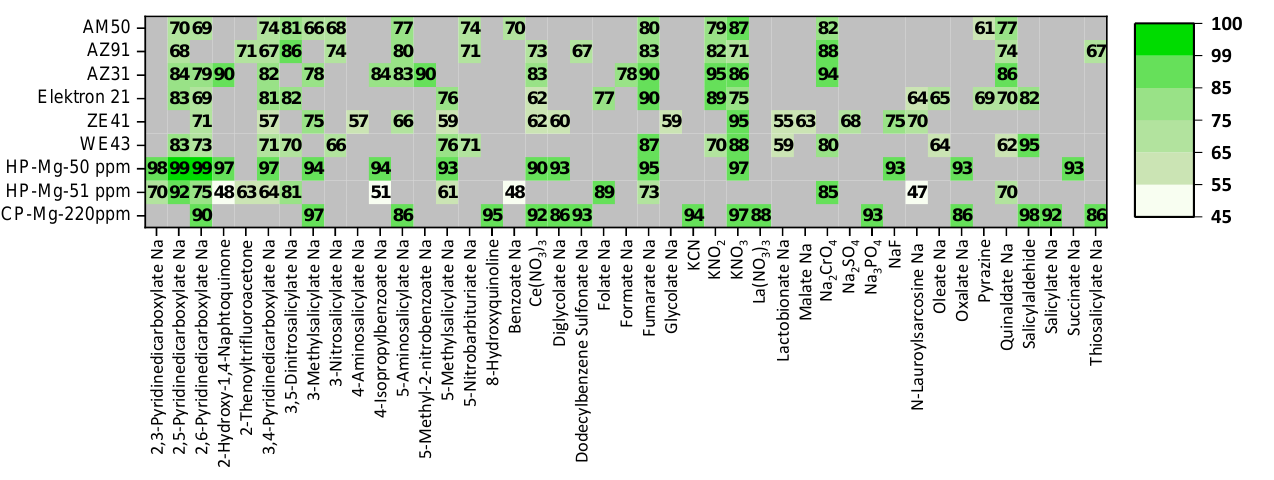
Figure 12. Inhibiting efficiency of top 15 corrosion inhibitors for pure Mg, RE, and Al containing Mg alloys. Based on the data presented in Table 5 of reference [10].